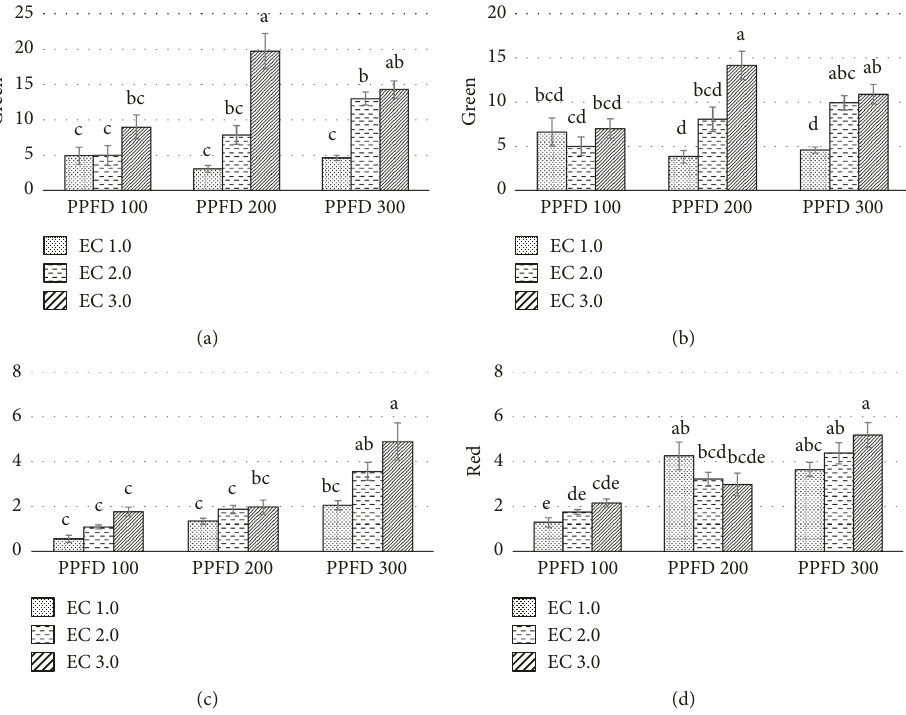
Figure 2: Content per plant in perilla plants after 5 weeks of cultivation under different LI and EC treatments. (a) AG content per plant ( µ g · plant − 1 ) in green; (b) LTcontent per plant ( µ g · plant − 1 ) in green; (c) AG content per plant ( µ g · plant − 1 ) in red; (d) LTcontent per plant ( µ g · plant − 1 ) in red. Values are mean ± standard error ( n � 5 − 6). Different letters indicate significant differences between at P < 0 . 05, as determined by Tukey’s